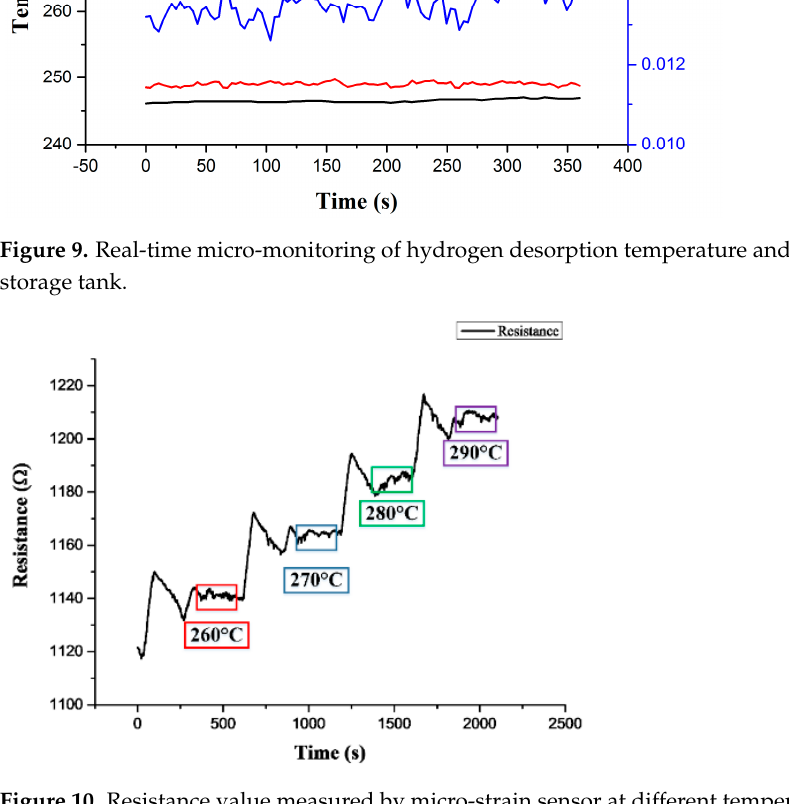
Figure 10. Resistance value measured by micro-strain sensor at different temperatures of hydrogen storage